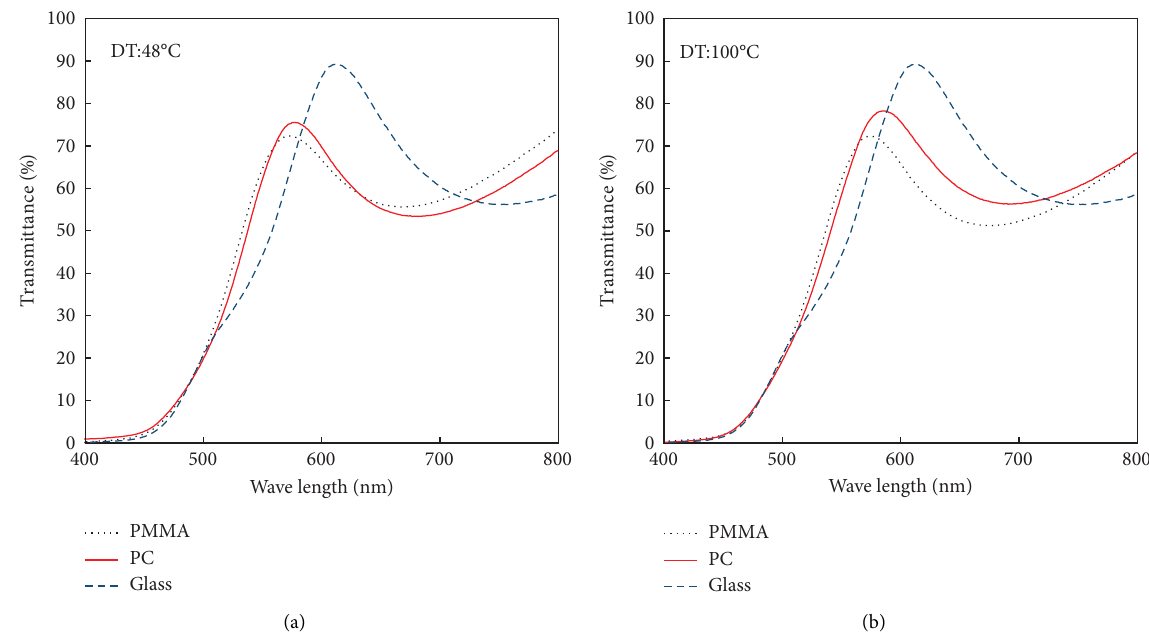
Figure 5: Transmittance of samples (a, b) that formed at 30W on PMMA, PC, and glass